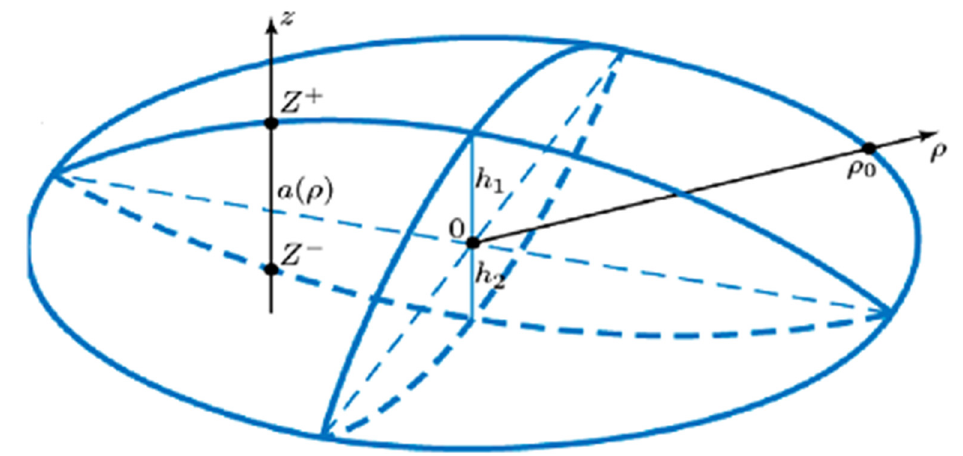
Figure 1. Schematic of the asymmetric biconvex lens-shaped QD.